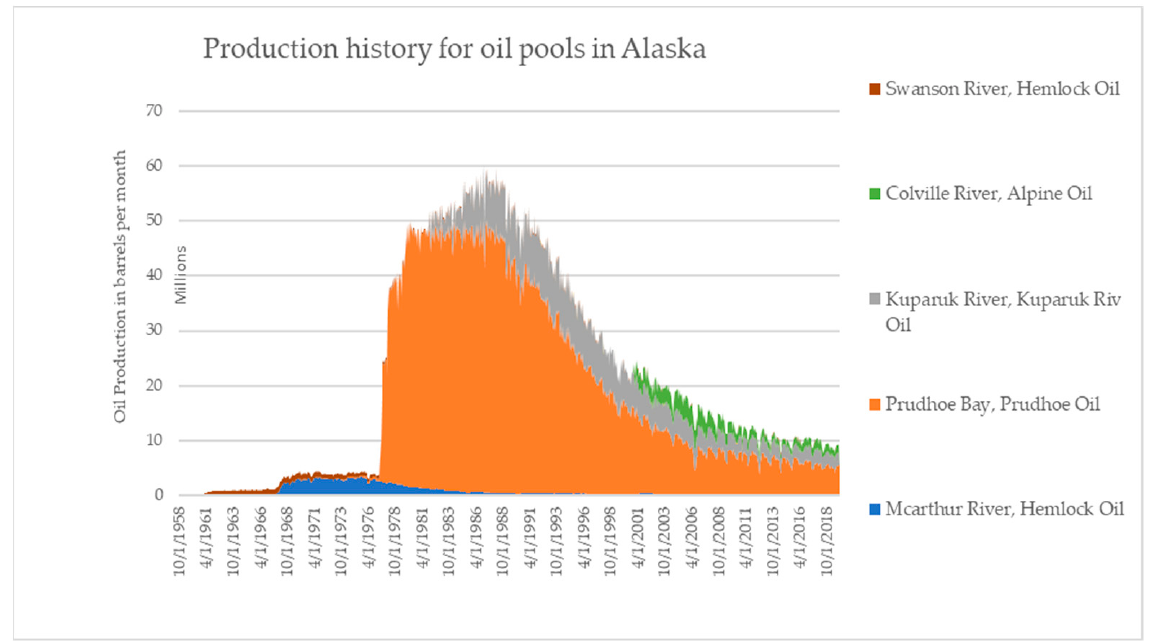
Figure 2. Production history of single pools in the major oil production fields in Alaska. Data was collected from publicly available sources [55].